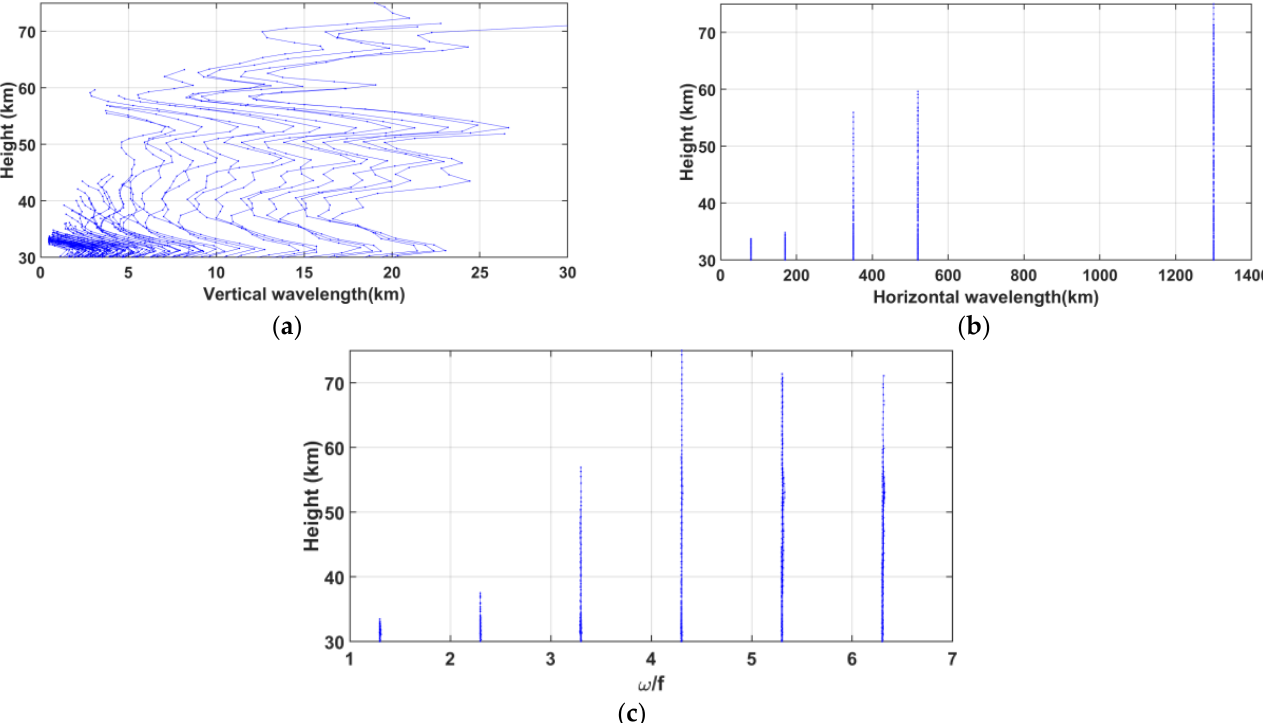
Figure 20. Forward trajectories of 90 individual modes from 9 October 2017 at 1200 UTC using ERA5 data with 137 model levels in 1D run on the vertical propagation only: ( a ) Altitude – vertical wavelength distribution, ( b ) altitude – horizontal wavelength distribution and ( c ) altitude –ω/f distribution.